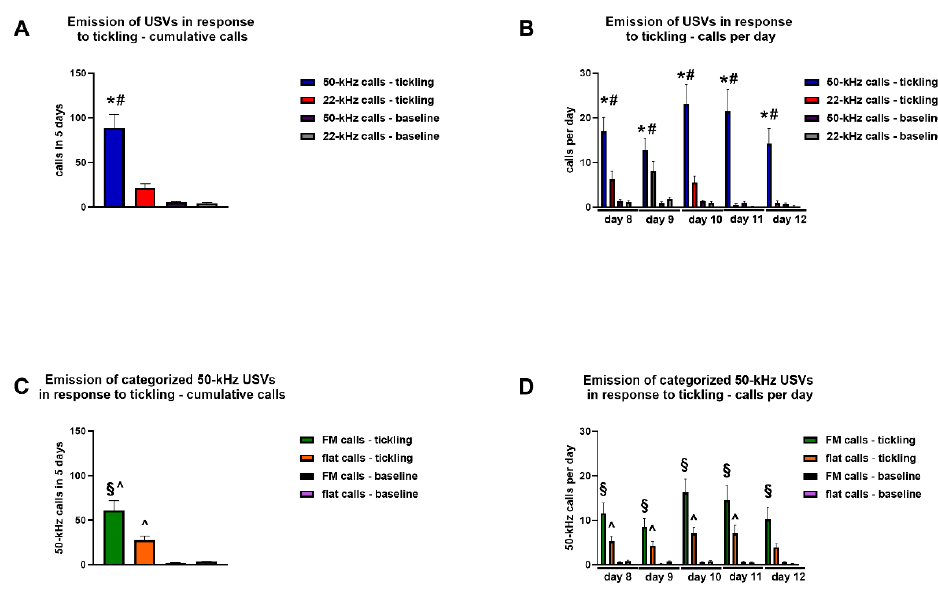
Figure 3. Emission of ultrasonic vocalizations in response to tickling. Rats underwent 1 cycle of tickling × day × 5 consecutive days, and each cycle of tickling consisted in blocks where no tactile stimulation was performed (baseline) alternated with blocks where tactile stimulation was performed (tickling). The emission of ultrasonic vocalizations was recorded throughout each cycle of tickling performed. Panel ( A ) demonstrates the cumulative numbers of 22-kHz and 50-kHz calls emitted over the 5 sessions of tickling. Panel ( B ) demonstrates the numbers of 22-kHz and 50-kHz calls emitted in each session of tickling. Panel ( C ) demonstrates the cumulative numbers of categorized 50-kHz calls emitted over the 5 sessions of tickling. Panel ( D ) demonstrates the numbers of categorized 50-kHz calls emitted in each session of tickling. * indicates a significant difference vs. 50-kHz calls—baseline. # indicates a significant difference vs. 22-kHz calls—tickling. § indicates a significant difference vs. FM calls—baseline. ^ indicates a significant difference vs. flat calls—baseline. FM = frequency modulated; USVs = ultrasonic vocalizations. n = 40.